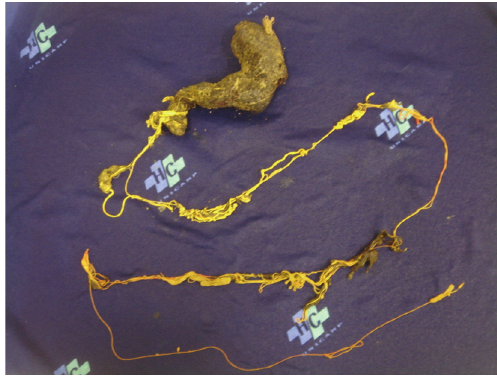
Figure 5: Trichobezoar and strands of 1.6 meters in length removed at